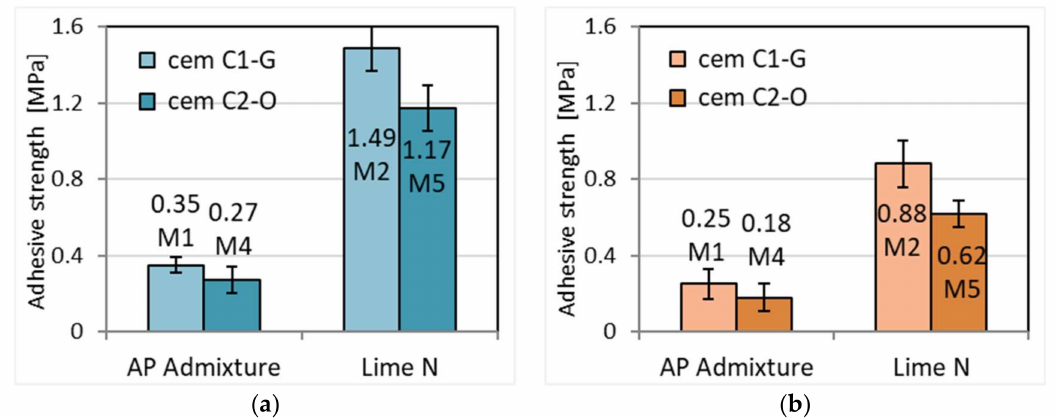
Figure 13. Adhesive strength of plasters ( a ) and masonry mortars ( b ) to concrete